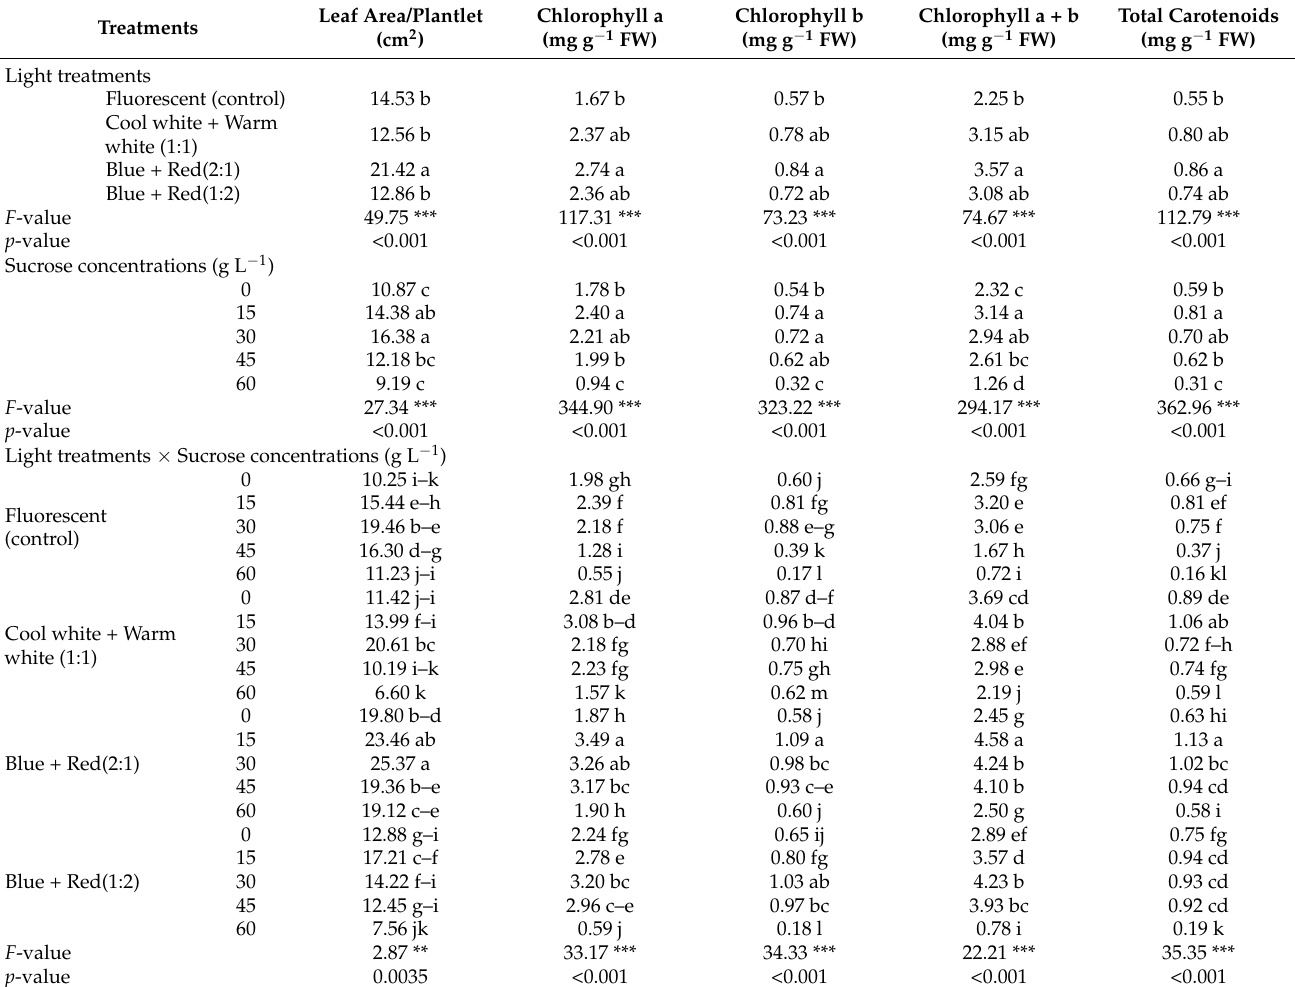
Table 3. Effect of light spectra and sucrose concentration treatments on leaf area and pigments of in vitro blackberry